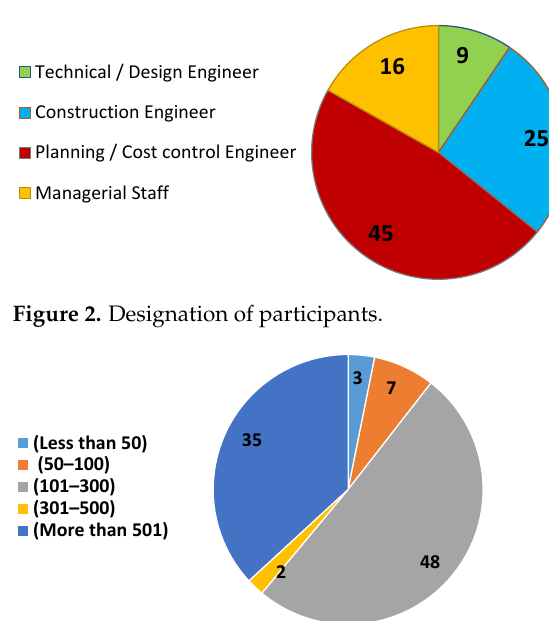
Figure 2. Designation of participants.